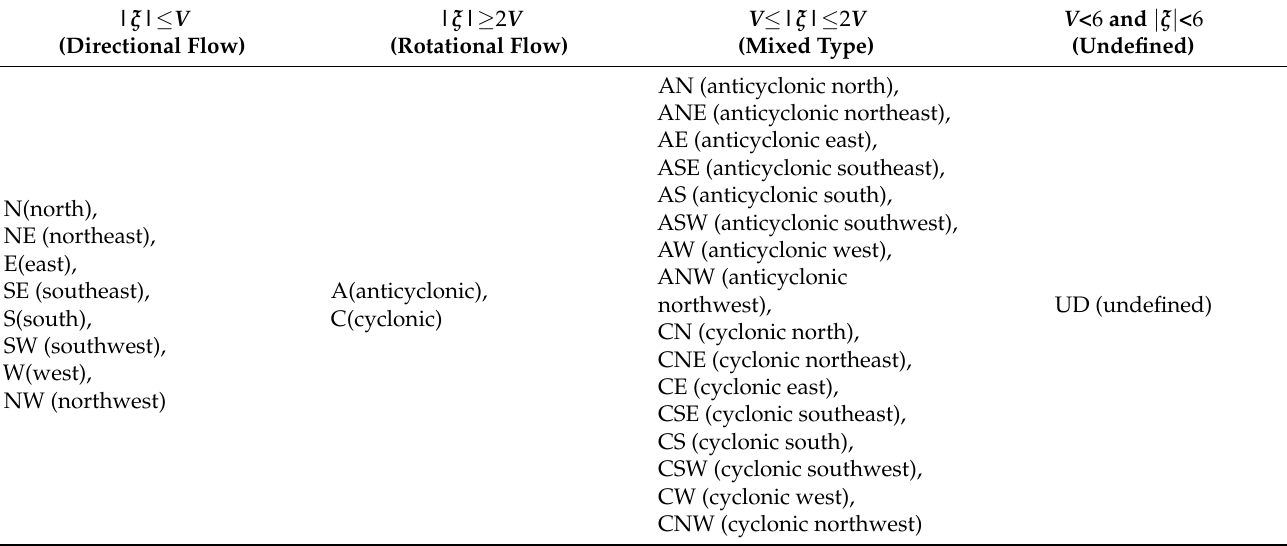
Figure 2. Average number of spring SDS days in China from 2000 to 2020, and the grid points of the three main regions of influence (A, B, C). Table 2. Circulation types based on the Lamb–Jenkinson